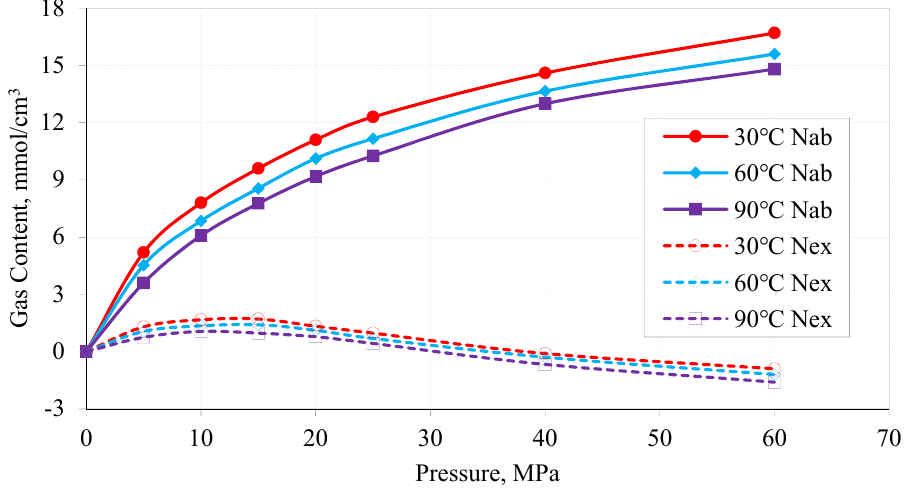
Figure 6. Methane isotherm adsorption curves at different temperatures.